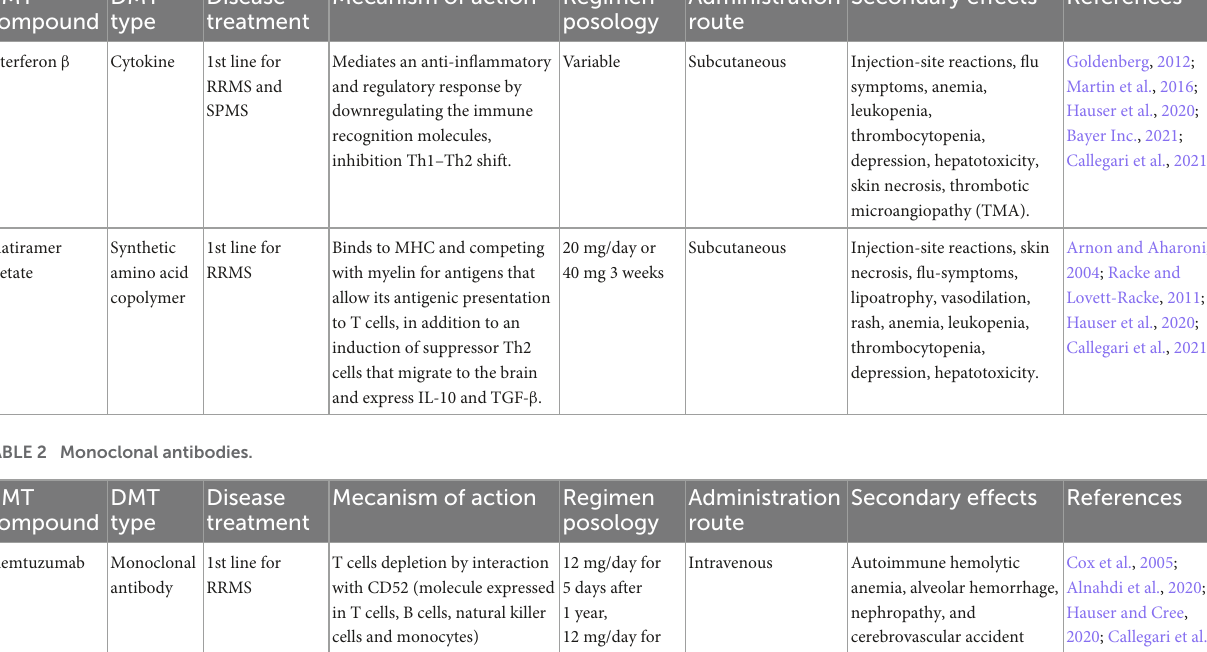
TABLE 1 Disease-modifying therapies (DMTs) approved for relapsing-remitting multiple sclerosis (RRMS).